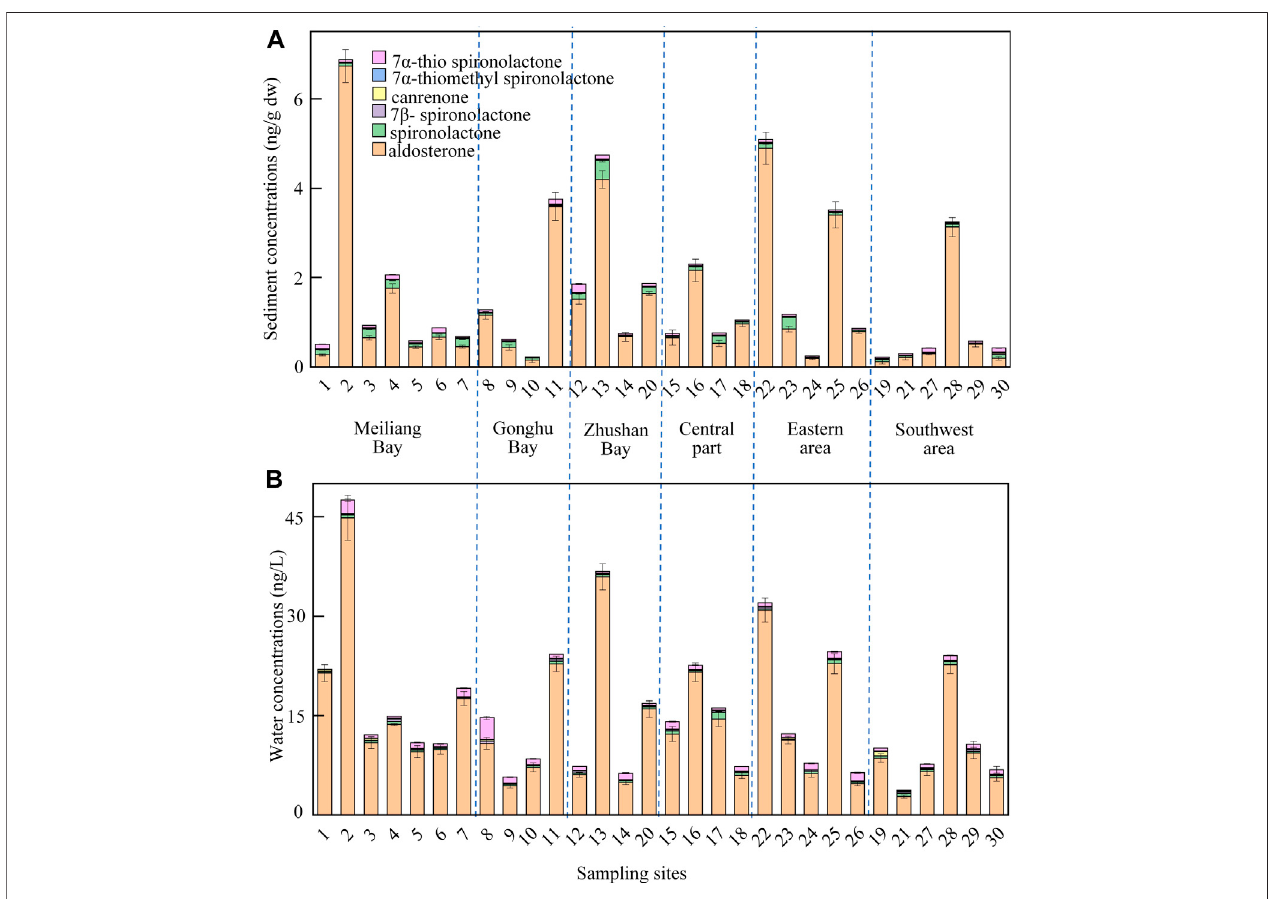
FIGURE 4 | Concentration distributions of the target mineralocorticoids detected in sediment (A) and water (B) samples from Taihu Lake. Error bars represent SD values of two duplicate composite samples.